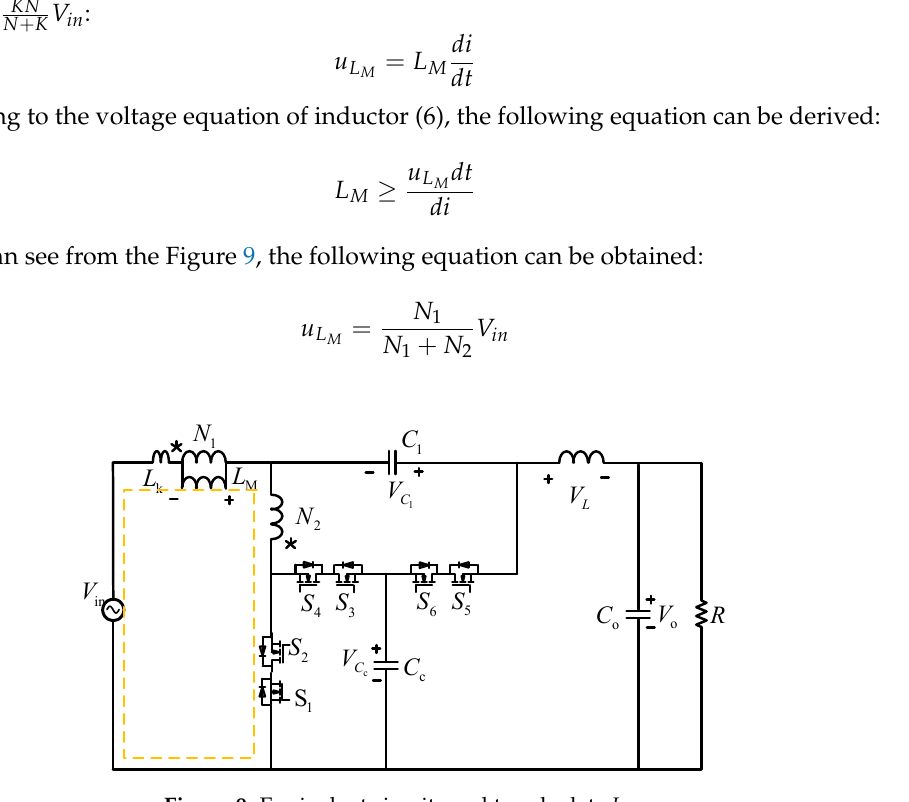
Figure 8. Switching strategy of the proposed converter.